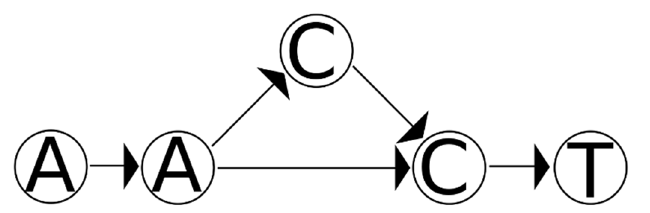
Figure 3. A variant graph for a mixture of two individuals involving an indel. A person of interest (POI) (AACCT) is mixed with another POI (AACT), and a variant graph is created to describe this mixture. A matching set of contributors must account for every node on this graph. Additionally, all edges must be accounted for if the indel is considered correctly.